Question: In a single sentence, describe what this figure presents.
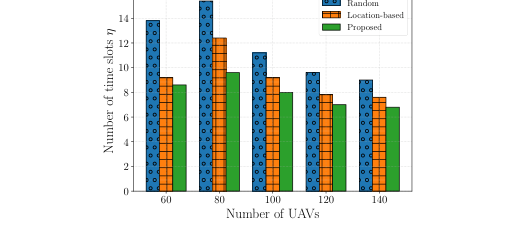
Answer: Number of time slots versus swarm size.